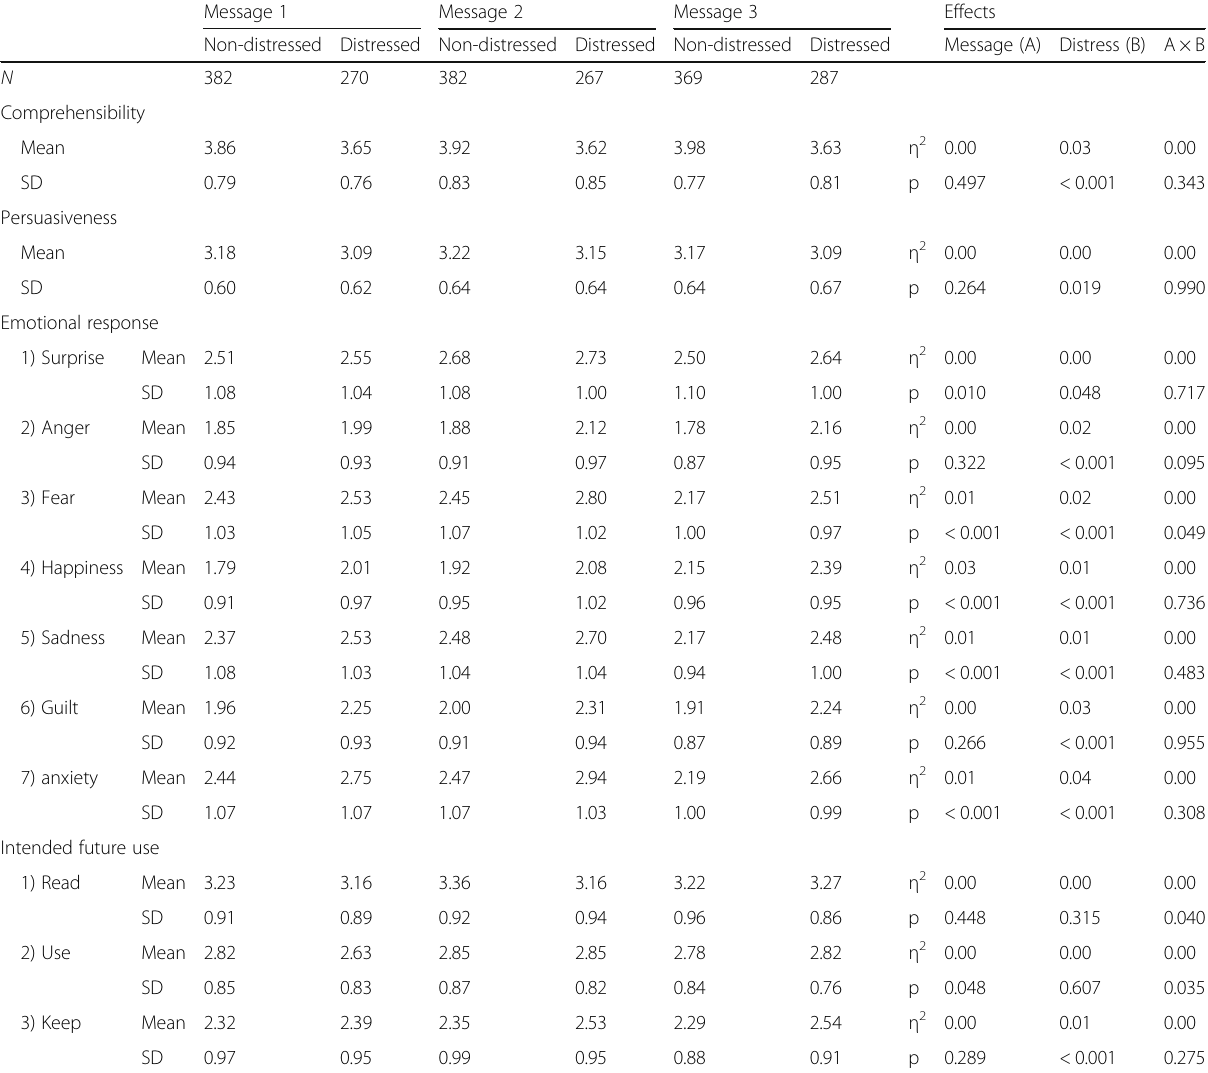
Table 2 Assessment of the persuasive messages encouraging help-seeking for depression Message